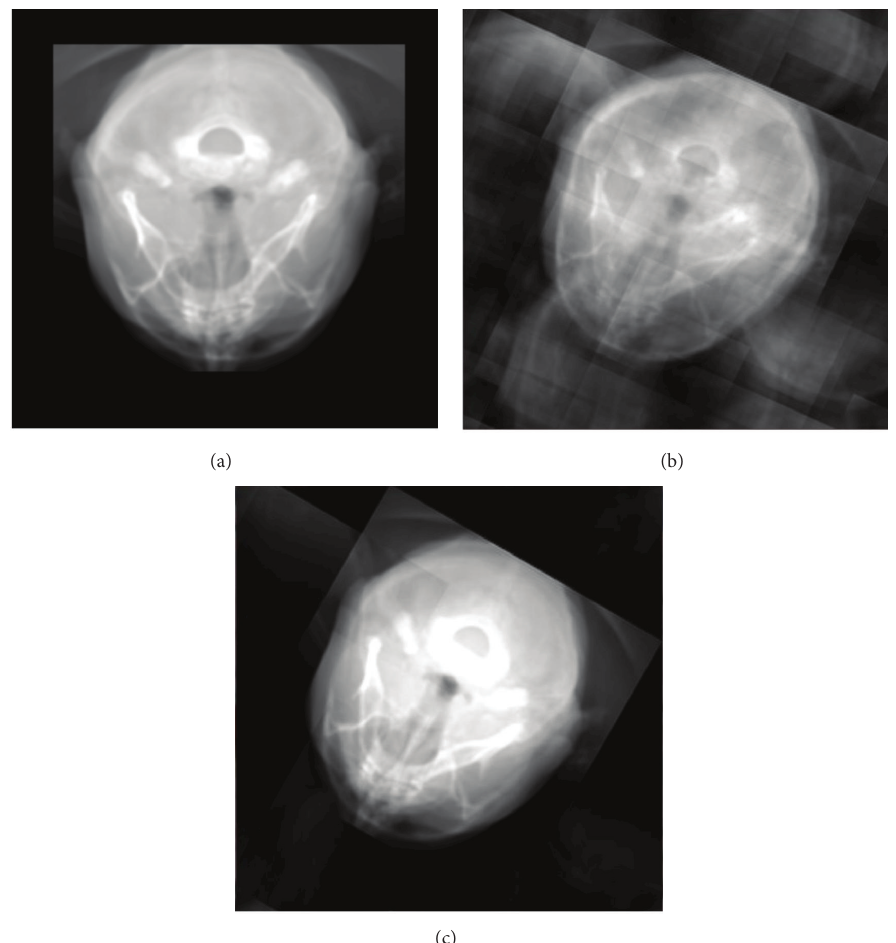
Figure 9: Results of rendering an axial projection of the visible male dataset with basic interpolation filters supported by OpenGL 3D textures. In (a), the projection of the dataset is orthogonal and the replicas are not shown. In (b) and (c), the volume is rotated and the ghosting artifacts are very apparent in (b) if a nearest-neighbour interpolation scheme is used and highly reduced if a trilinear interpolation filter is applied as shown in (c). Applying trilinear filtration on the spectral slice significantly affects the rendering performance if the slice size is greater than 512 2